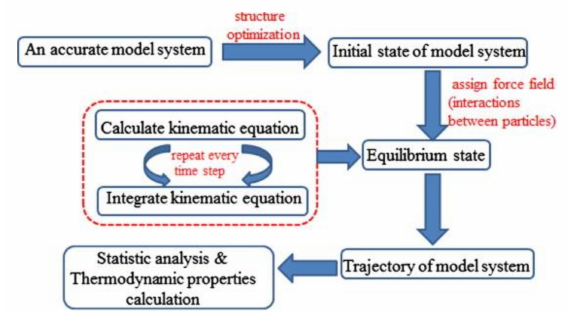
Figure 3. The flow chart of MD simulation